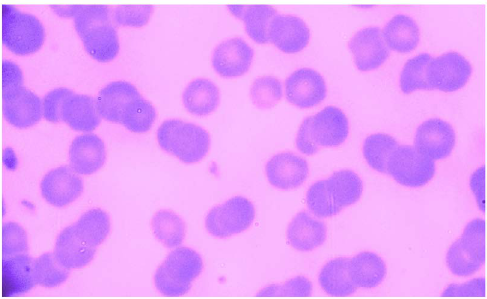
Table 2. Cross-classification results of microscopy and